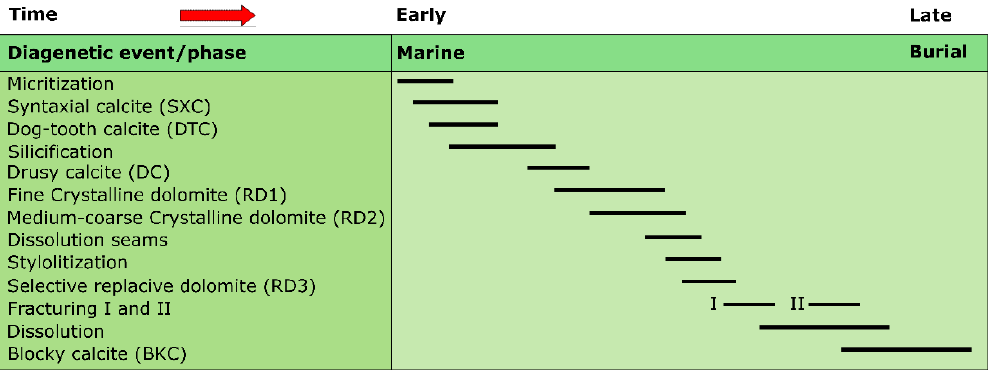
Figure 20. Paragenesis of Devonian Formations (modified from Tortola [46]).